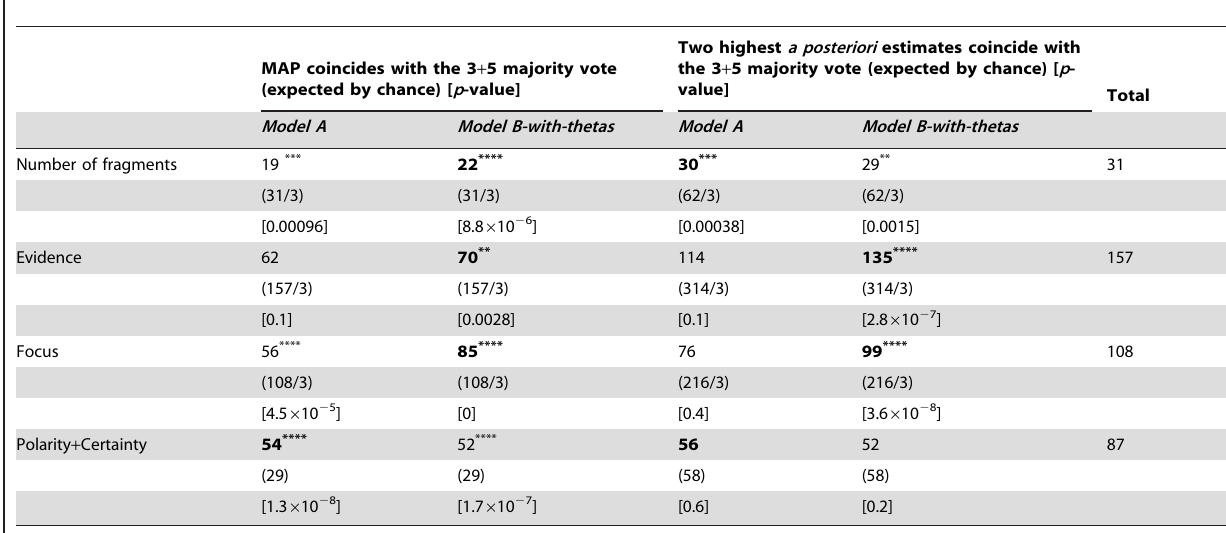
Table 2. Comparison of two models, A and B-with-thetas , in terms of their efficiency of resolving three-way ties among three